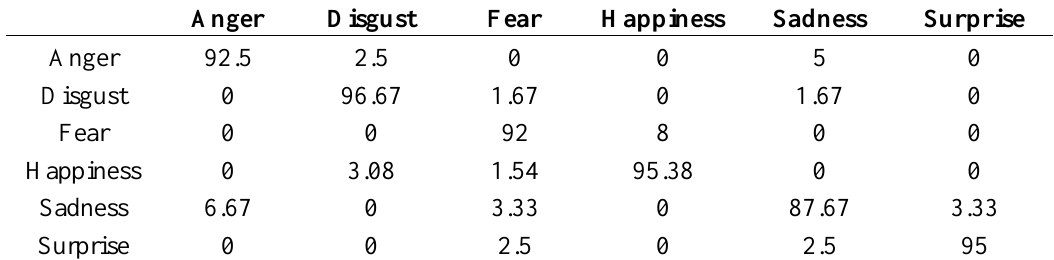
Table 4. Confusion matrix for facial expression recognition in percentages, using SVM with boosted features (100 AdaBoost selected features).